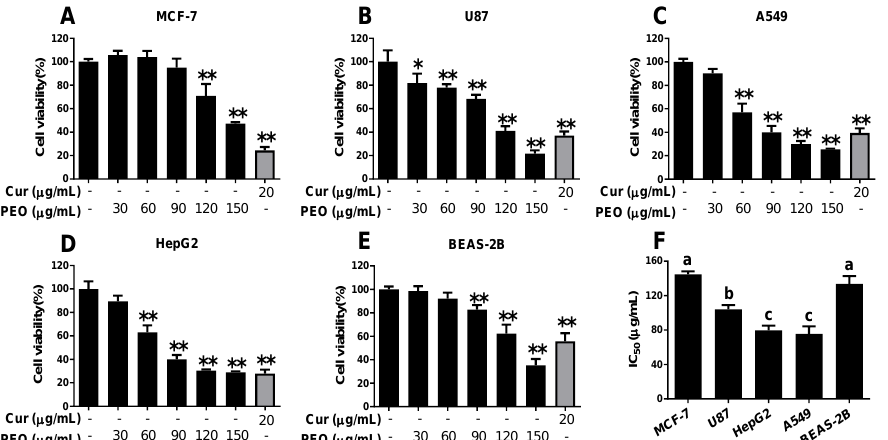
Figure 2. Cytotoxicity of PEO against different tumor cell lines. Four tumor cell lines ( A ) MCF-7, ( B ) U87, ( C ) A549, ( D ) HepG2, and ( E ) one normal human bronchial epithelial cell line BEAS-2B were treated with or without different concentrations of PEO for 24 h, then cell viabilities were determined by CCK8 method. ( F ) The IC 50 of PEO against five cell lines were calculated. The values represent mean ± standard deviation of three independent experiments. * p < 0.05, ** p < 0.01 compared with the untreated group. Different letters indicate significant differences, p < 0.05.